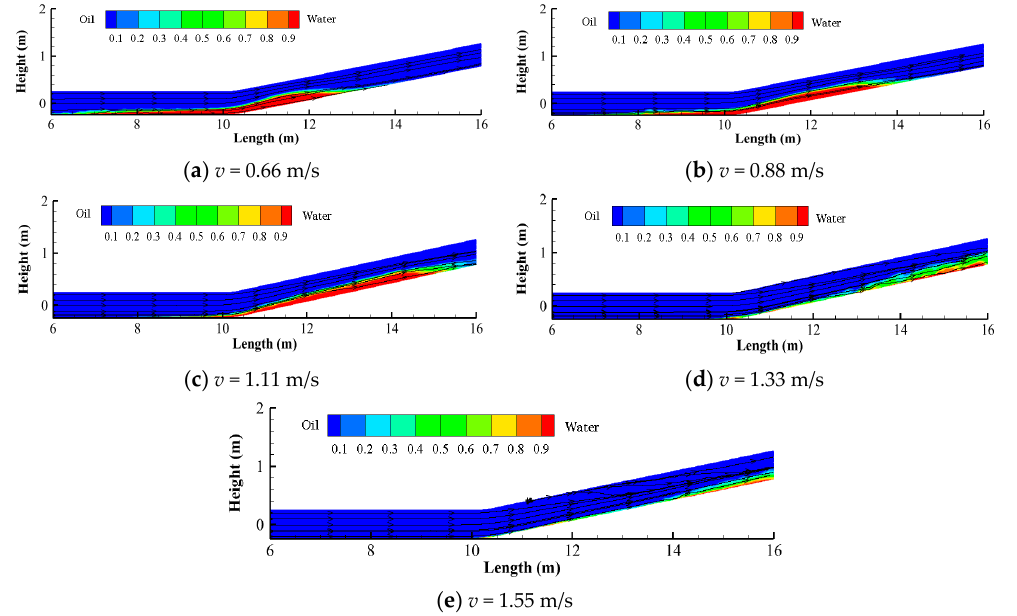
Figure 10. Distribution of oil and water ( α = 10°, t = 11.0 s).